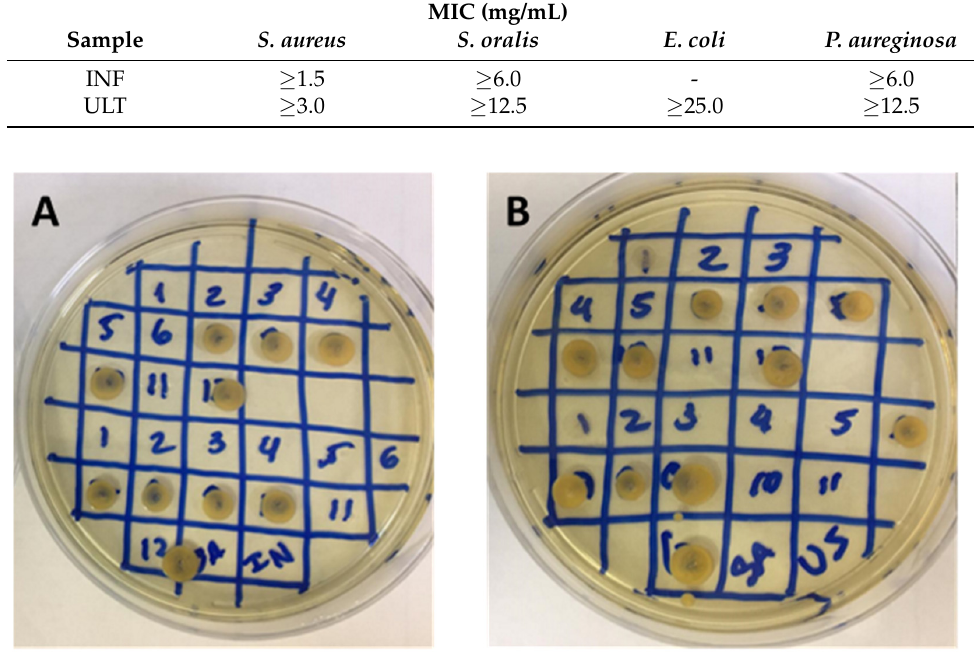
Figure 4. MIC assay of infusion ( A ) and ultrasound ( B ) extracts with different sample concentrations in a Petri plate. Microorganism growth was observed in diverse concentrations, as shown by the numbers. Number 12 is a positive control of microorganism